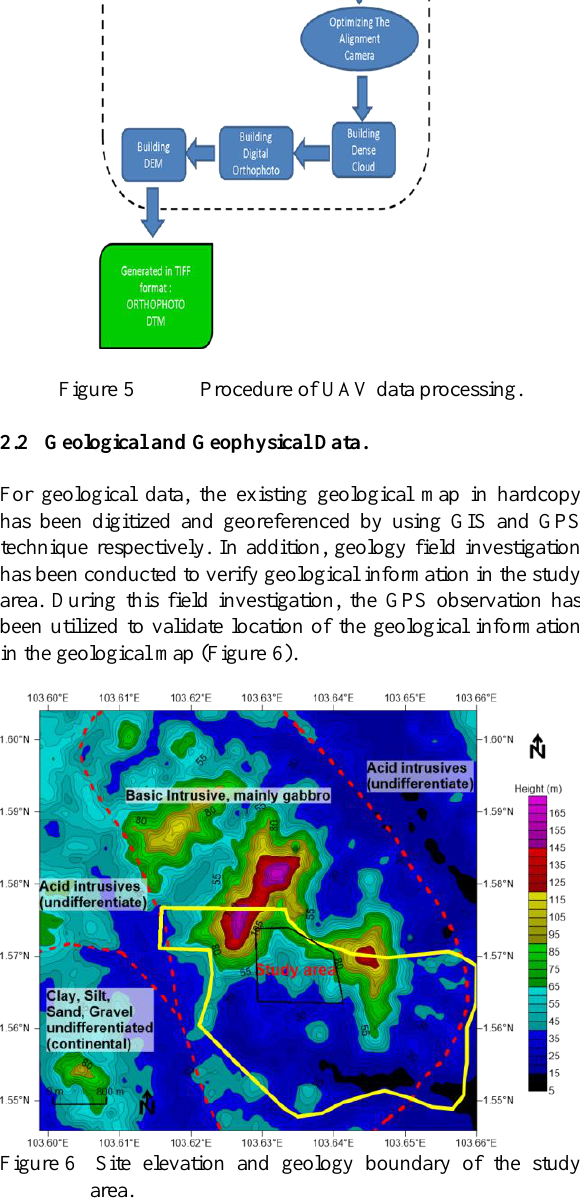
UAV flight plan.